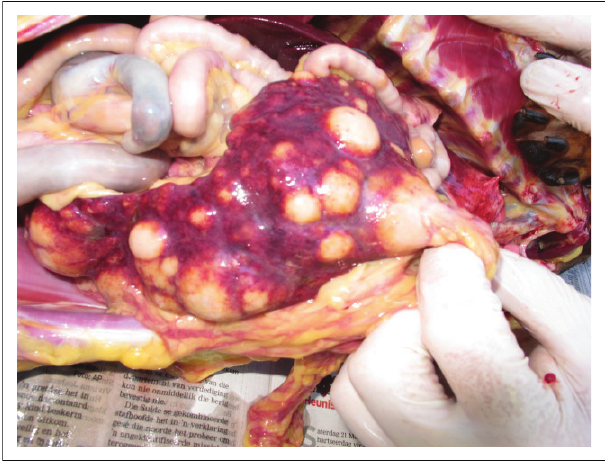
FIGURE 4: Multifocal lesions in spleen on post-mortem